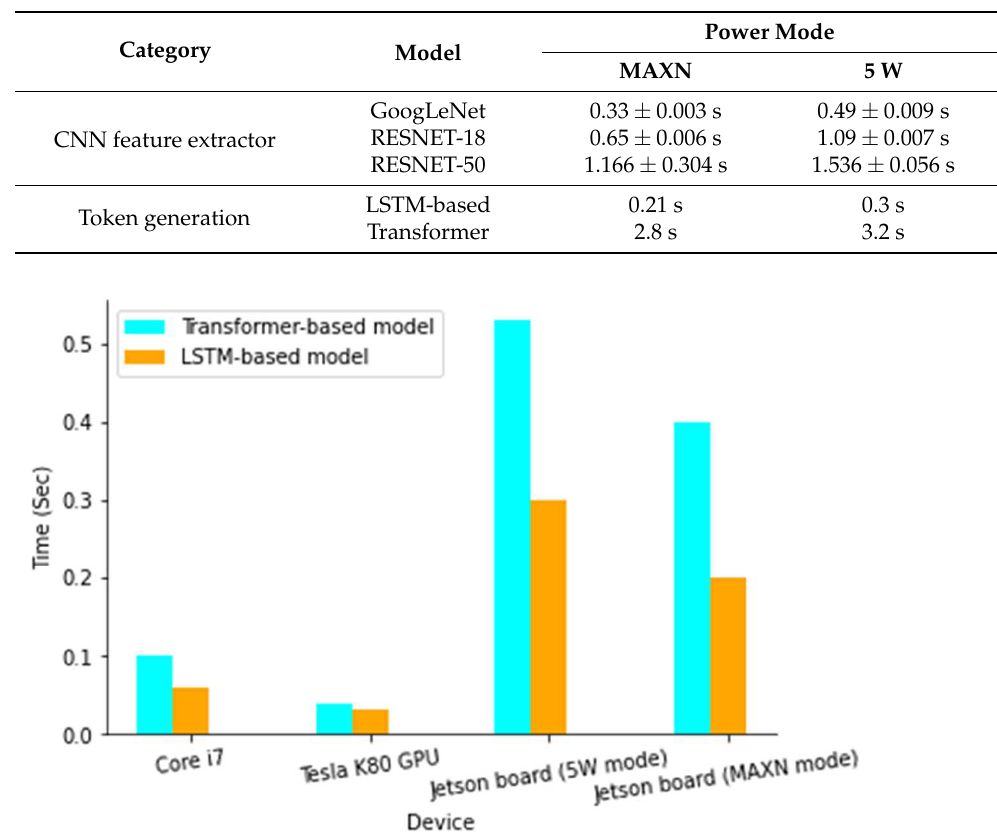
Table 3. Time cost (in seconds) for a single inference by the CNN and for generating one token by the video captioning models on both power modes of the Jetson nano board.